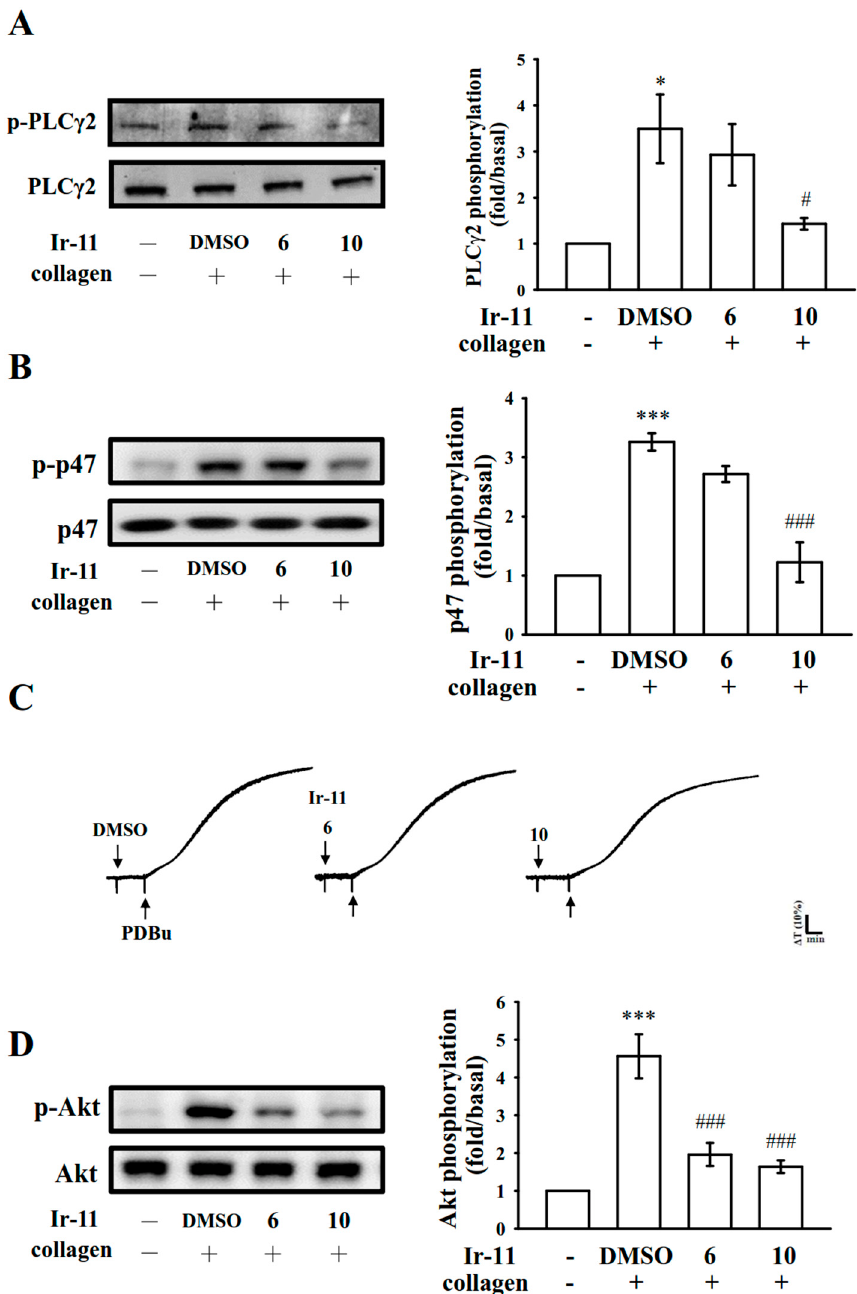
Figure 4. Inhibitory effects of Ir-11 on PLC γ 2, PKC, and Akt activation in platelets. Washed platelets were preincubated with the solvent control (0.1% DMSO) or Ir-11 (6 and 10 µM), and subsequently treated with collagen (1 µg/mL) or PDBu (150 nM) to induce ( A ) PLC γ 2 and ( B ) PKC activation (p47, pleckstrin phosphorylation), ( C ) platelet aggregation, and ( D ) Akt phosphorylation. Platelets were collected, and their subcellular extracts were analyzed to determine the levels of protein phosphorylation. Data are presented as means ± standard error of the means ( n = 4). * p < 0.05 and *** p < 0.001, compared with the resting control; # p < 0.05 and ### p < 0.001, compared with the DMSO-treated group. The profiles in ( C ) are representative of four independent experiments.